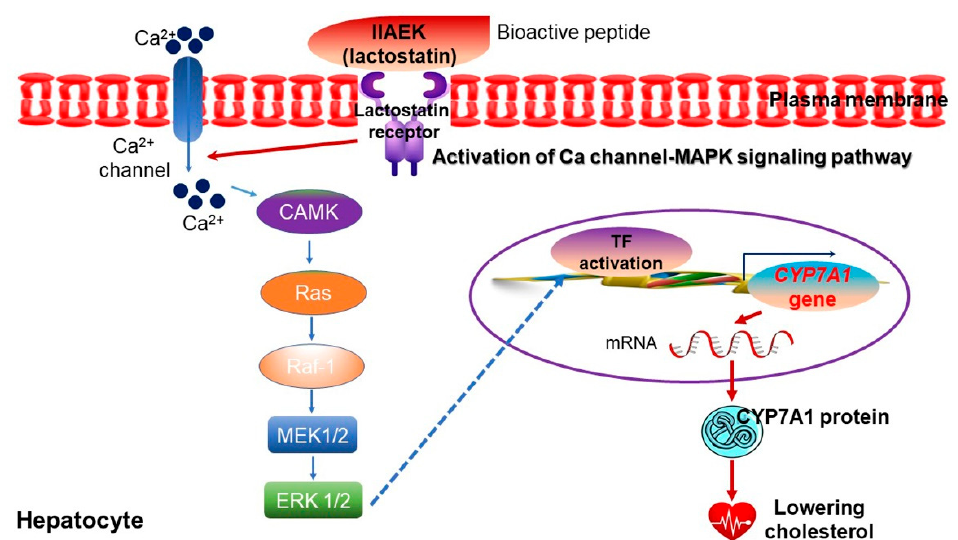
Figure 12. Mechanism of cholesterol degradation through lactostatin (IIAEK)-driven CYP7A1 ex- pression in hepatic carcinoma HepG2 cell line. CYP7A1, cytochrome P450 monooxygenase; CAMK, calmodulin kinase; ERK, extracellular-signal-regulated kinase; MEK, mitogen-activated protein kinase kinase; Ras, a small GTPase protein; Raf-1, proto-oncogene serine/threonine-protein kinase; TF, transcription factor. Figure adapted from Nagaoka, S. [150].